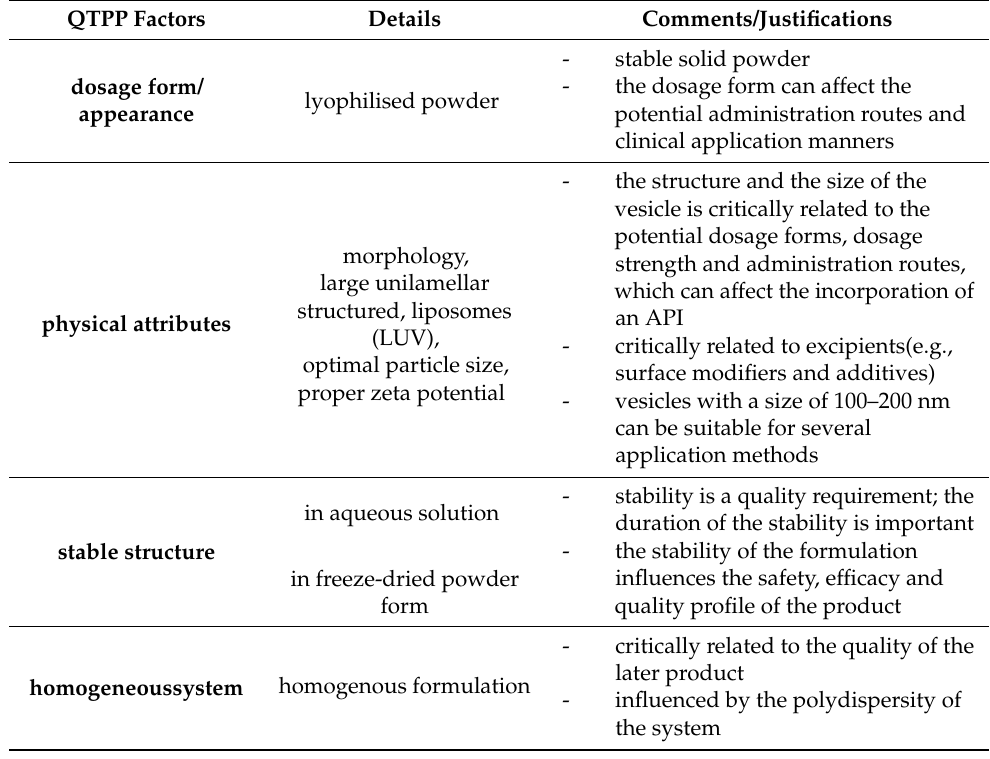
Table 5. QTPP elements of the “intermediate” liposomes designed as optimal carrier systems.